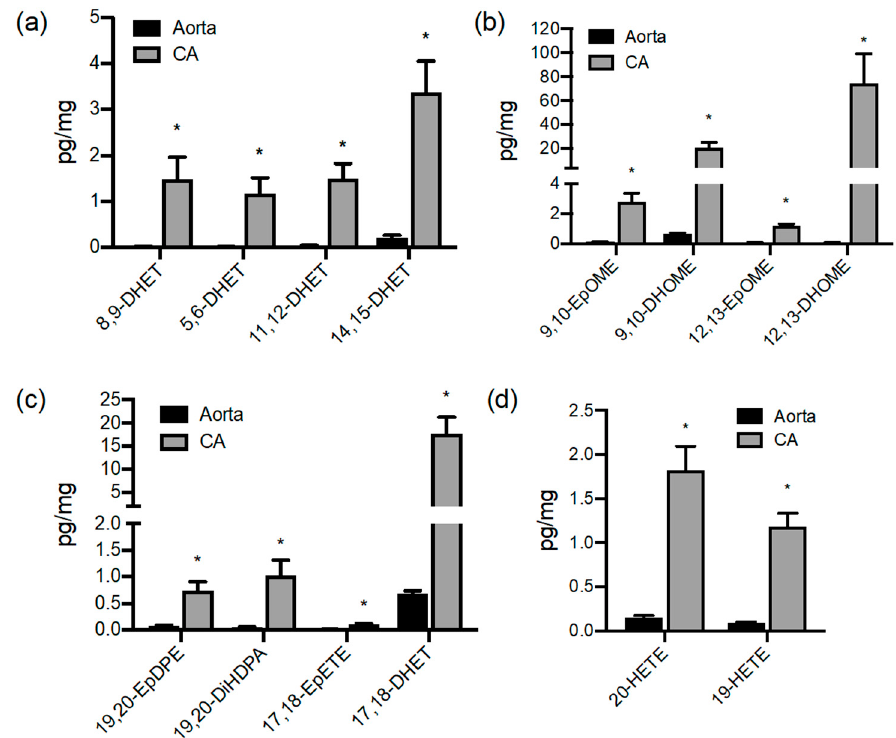
Figure 2. Coronary arteries produce high levels of CYP-derived oxylipins. Figures show detectable CYP epoxygenase ( a ) EPOX-AA, ( b ) EPOX-LA, ( c ) EPOX-DHA / EPA and ( d ) CYP-OH products released by pig aorta (black bars) and coronary artery (grey bars). Oxylipins accumulated in 24 h serum-free organ culture were measured by LC–MS / MS and expressed as pg / mg of wet tissue weight. Data represents organ culture from n = 3–4 separate animals. Data represents organ culture from n = 3–4 separate animals. * indicates p < 0.05 between Aorta and CA.